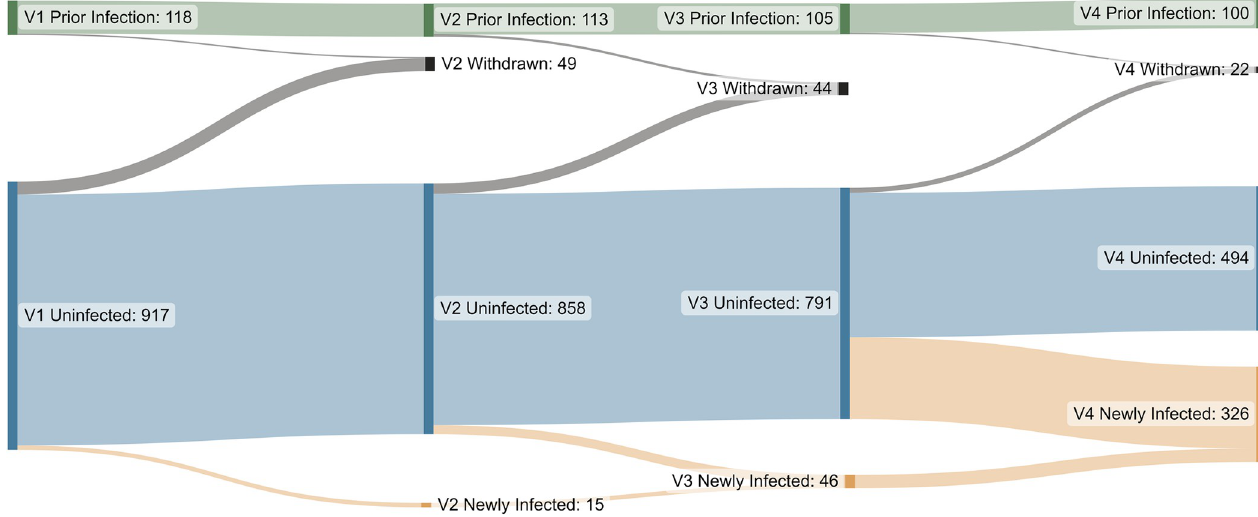
Fig 2. Participant reallocation between groups from Visit 1 (left-hand side) to Visit 4 (right-hand side). Participants with SARS-CoV-2 infection prior to enrolment shown in green, participants uninfected at enrolment who remained uninfected in blue, and newly infected participants who acquired SARS-CoV-2 infection between study visits in orange. There were 115 total participant withdrawals in